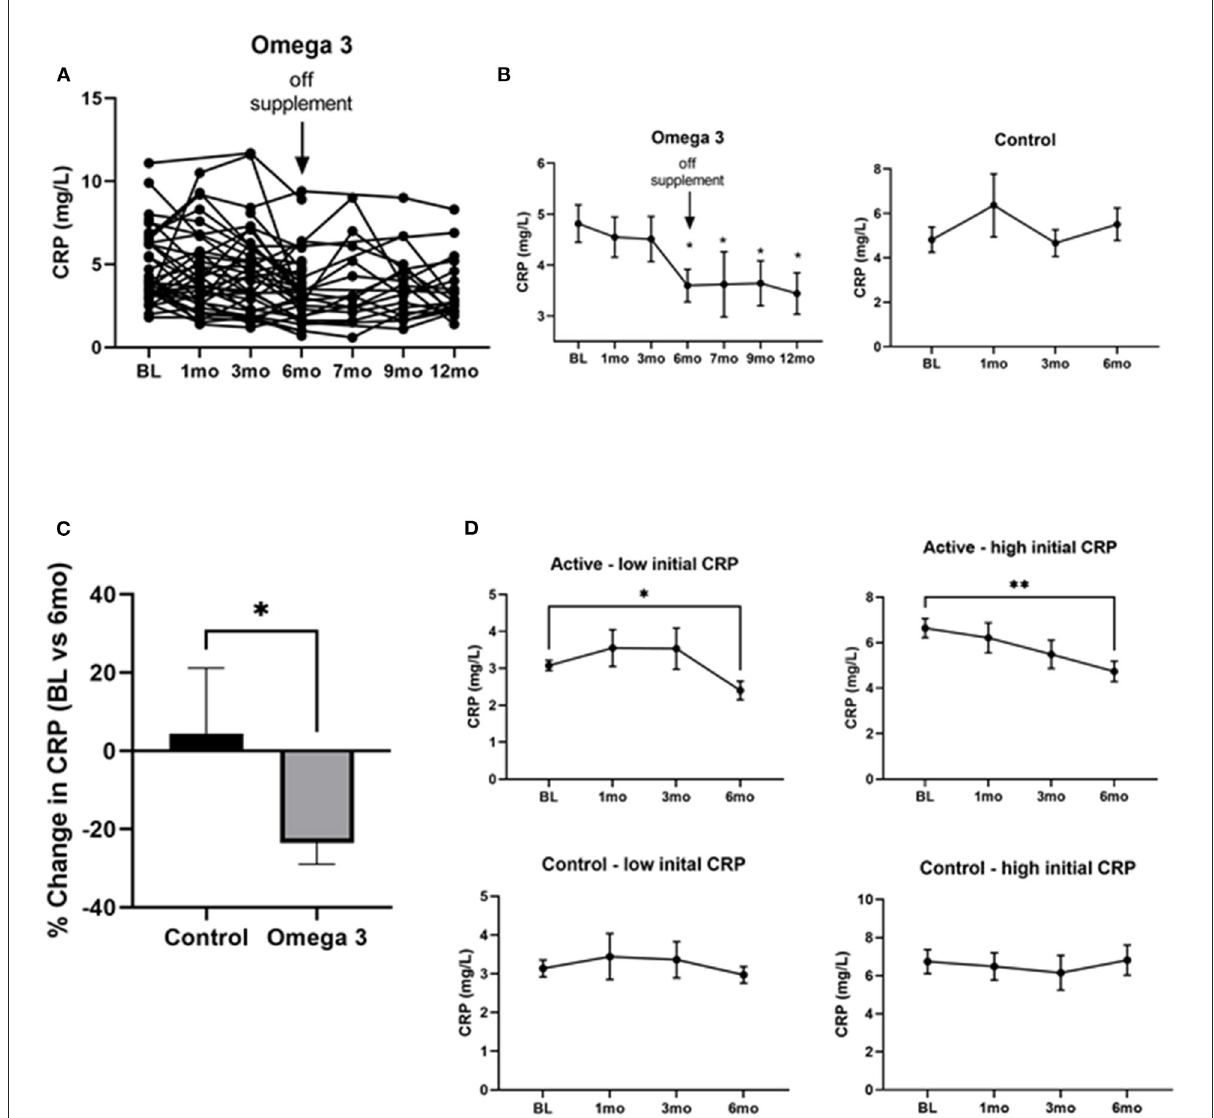
FIGURE4 Omega 3 supplements significantly reduce CRP levels in participants with high initial CRP levels ≥ 4 mg/L. (A) Individual CRP levels of the participants on omega 3 for 6 months, as determined by high sensitivity ELISAs. (B) Average plasma CRP levels over time in the omega 3 treated group vs. the untreated group. All average values shown are the mean ± SEM of duplicate determinations. (C) Percent average change in CRP levels in the control and omega 3 group after 6 months, relative to their BL levels. (D) Changes in CRP levels in participants taking (active) and not taking omega 3 supplements (control) with low vs. high initial CRP levels. *Denotes significant ( P < 0.05) difference when compared to baseline values. **Denotes significant ( P < 0.01) difference when compared to baseline values.